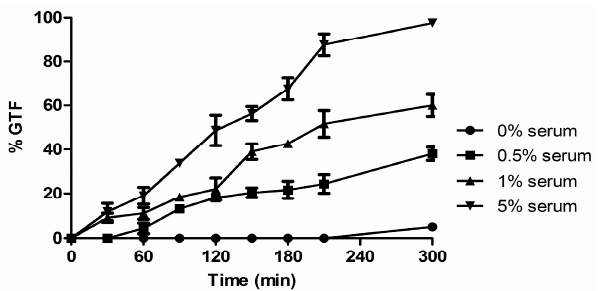
Figure 4. Effect of serum concentration on % GTF in C. albicans . Three times washed inocula were incubated at 37 ◦ C with rotary agitation at 220 rpm. Cultures were observed for 5 h, and plotted as , no serum (water control); (cid:4) , 0.5% serum; (cid:78) , 1% serum; and (cid:72) , 5% serum. Values shown are the average of triplicate experiments ± SD.